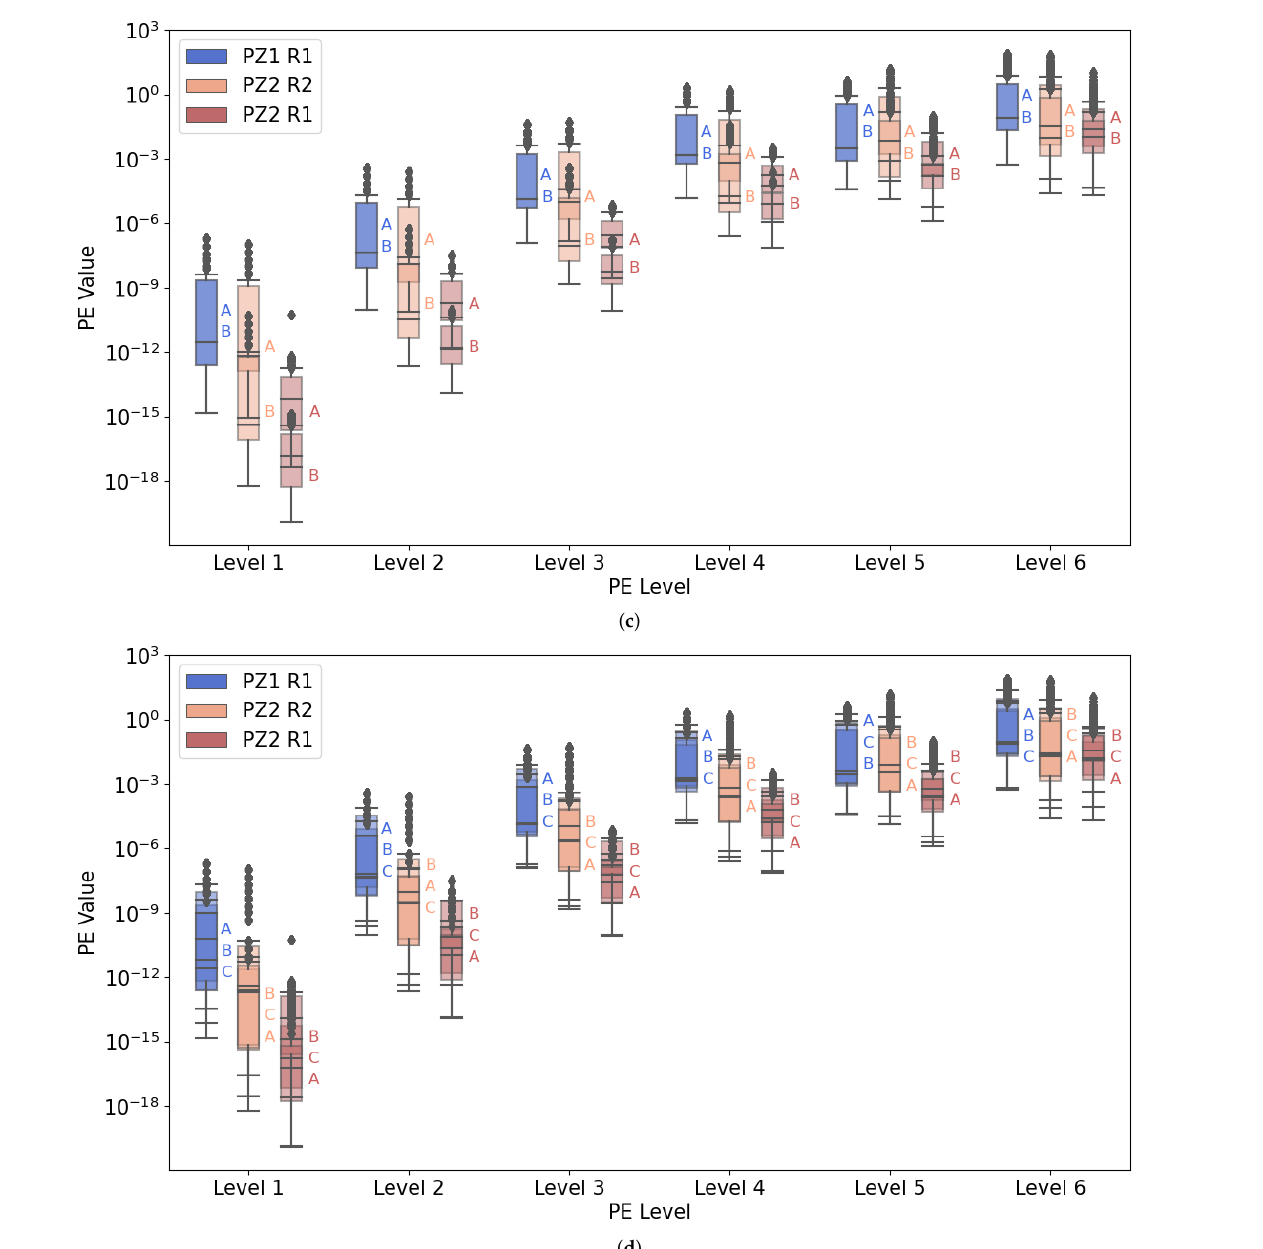
Figure 6. Steady-state PE values distribution per protection zone under several system elements com- binations. ( a ) Box plot for each capacitor bank combination from Table 2, shown as letters next to the box plots. ( b ) Box plot for each lateral combination from Table 3, shown as letters next to the box plots. ( c ) Box plot for each regulator combination from Table 4, shown as letters next to the box plots. ( d ) Box plot for each PZ configuration combination from Table 5, shown as letters next to the box